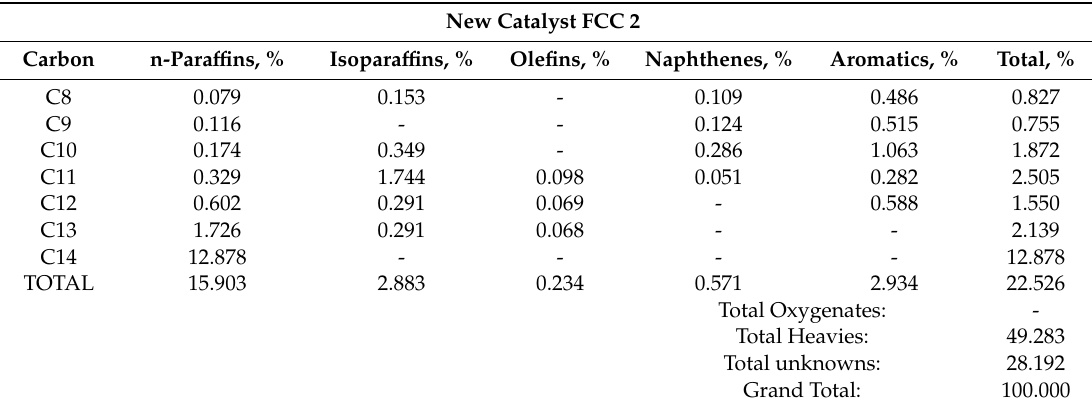
Table 23. Total composition results by group type and carbon number, as a percentage of the mass of catalyst New FCC 2.